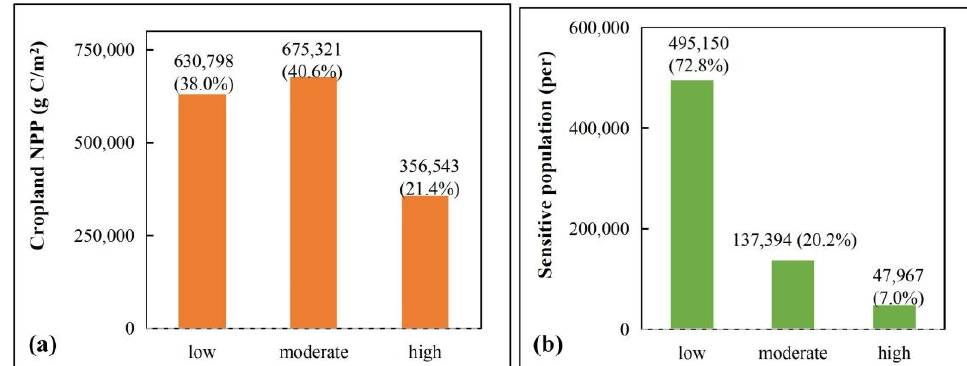
Figure 6. The 1km scale risk assessment for ( a ) cropland, ( b ) sensitive populations, and ( c ) overall risk in Yunnan. In Honghe City, the risk assessment is shown for ( d ) cropland, ( e ) sensitive populations, and ( f ) overall risk. PHA is the potentially hazardous area simulation.